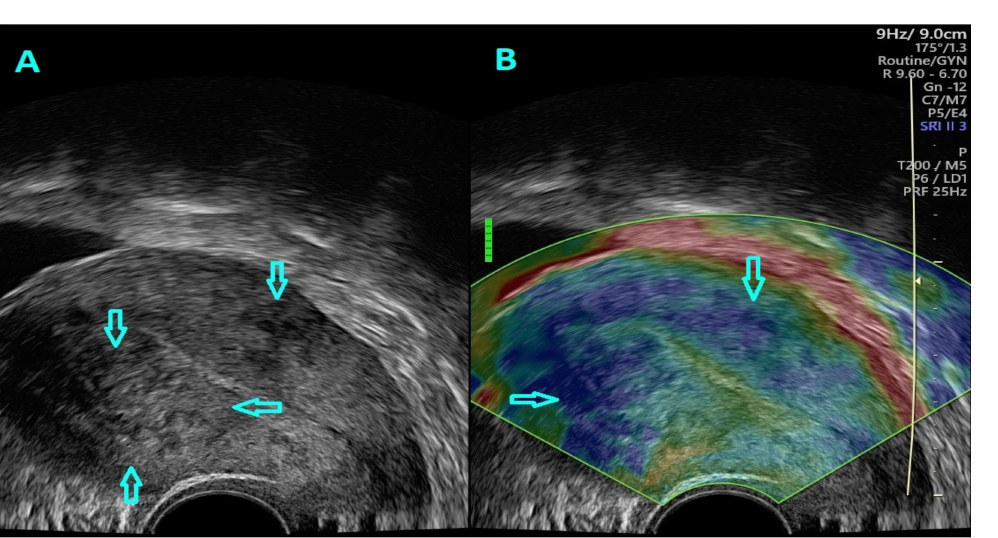
Figure 2. ( A ) B–mode, TVUS characteristics of uterine adenomyosis (superior part of the image) and a uterine fibroid (inferior part of the image) (pointed out through the arrows) ( B ) SRE evaluation of an image acquired through dual-mode, real–time TVUS which depicts coexisting adenomyosis and a uterine